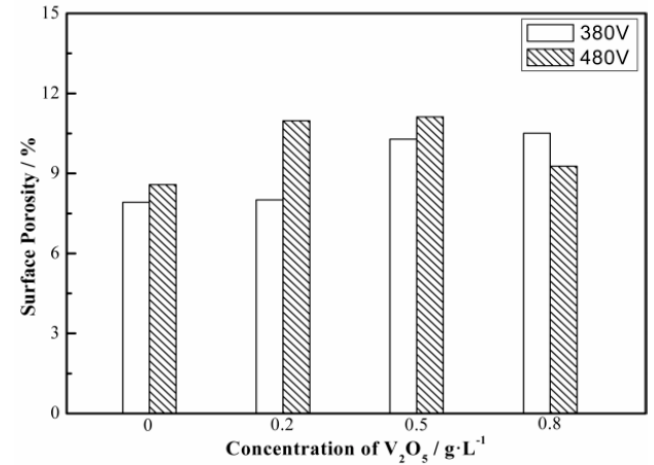
Figure 5. Statistical data of the surface porosity of MAO coatings with different V 2 O 5 contents.